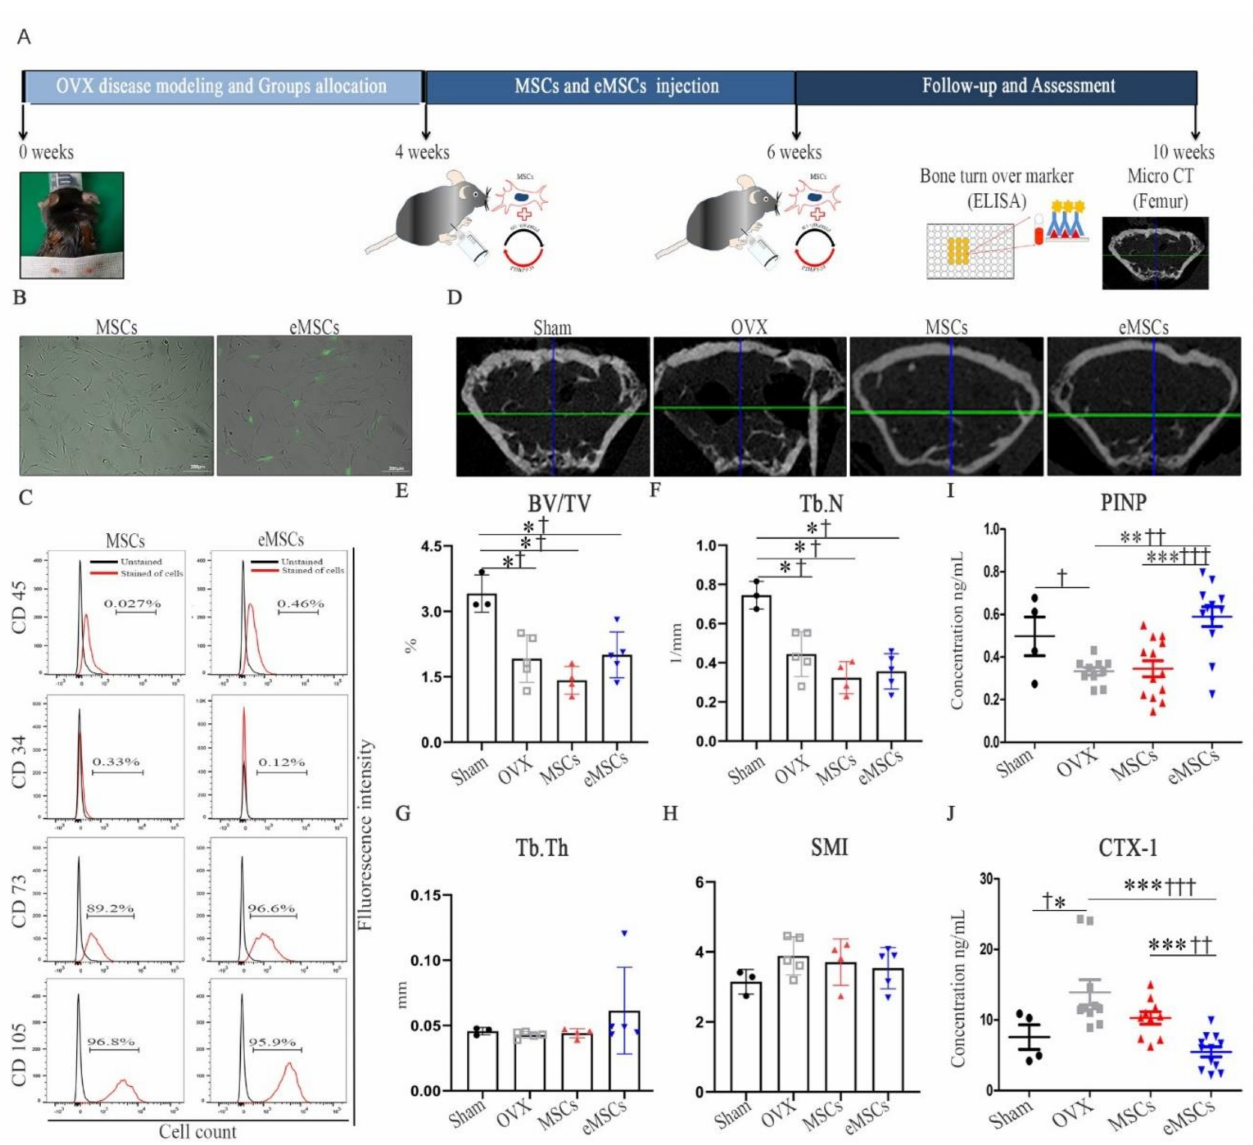
Figure 4. Therapeutic effect of eMSCs in OVX mice. ( A ) Experimental timeline. MSCs and eMSCs were injected twice at weeks 4 and 6 after ovariectomy, intraperitoneally. ( B ) Fluorescence images showing the expression of GFP 48 h post- transfection with mcPTHrP 1–34+107–139; scale bar = 200 µ m. ( C ) MSC-specific marker expression in MSCs and eMSCs; black and red histograms represent unstained and stained cells, respectively. ( D ) Representative 2D micro-CT images of the femurs of the different groups of mice. The ( E ) regenerated trabecular bone volume fraction (BV/TV), ( F ) trabecular number (Tb.N), ( G ) trabecular bone thickness (Tb.Th) quality, and ( H ) trabecular bone structural model index (SMI) quality were determined in the femurs of each group. The levels of ( I ) PINP and ( J ) CTX-1 were also measured in serum samples collected from the different groups of mice, 10 weeks after surgery. The data are represented as the mean ± SEM. Statistical significance was assessed using the Kruskal–Wallis test with LSD (†) post hoc analysis and the Mann–Whitney (*) test: *† p < 0.05, **†† p < 0.01, ***††† p < 0.001, n.s. = not